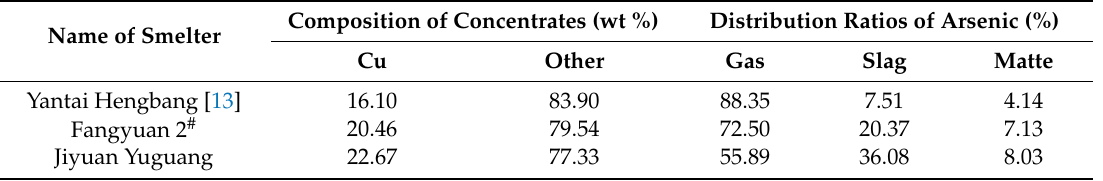
Figure 10. Optimization of ore proportions for arsenic removal in the Fangyuan 1 # smelter.